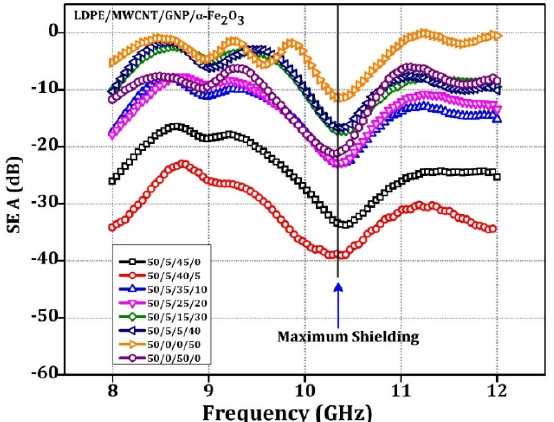
Figure 7. The SE A Vs. Frequency for 3.5 mm thick sample of LDPE: MWCNT: GNP: α -Fe 2 O 3 matrix nanocomposite specimens.